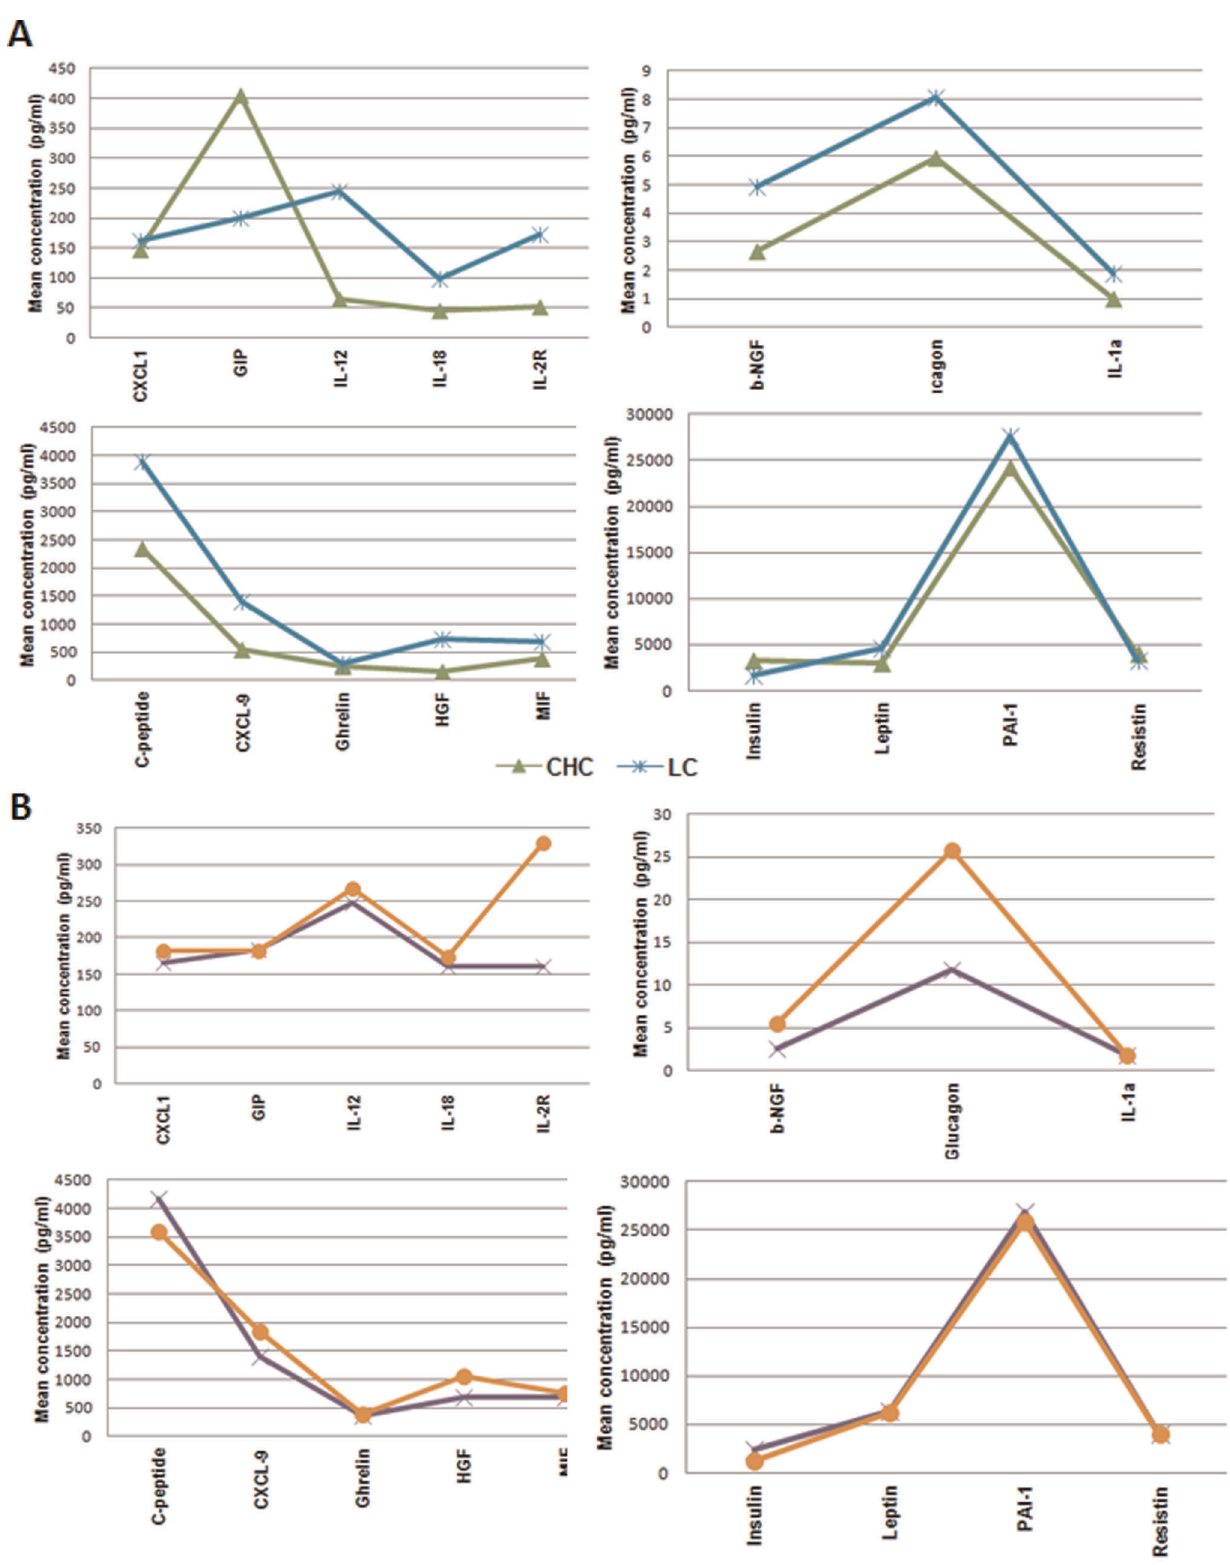
Figure 3. Mean concentrations of significant cytokines. We report the mean levels of the molecules evaluated in patients with chronic hepatitis C (CHC) and CHC-related cirrhosis (LC) (A), and with CHC hepatitis and type 2 diabetes (CHD) and CHC-related cirrhosis and type 2 diabetes (LCD) (B). The legends evidence the different colors used for the analyzed groups.